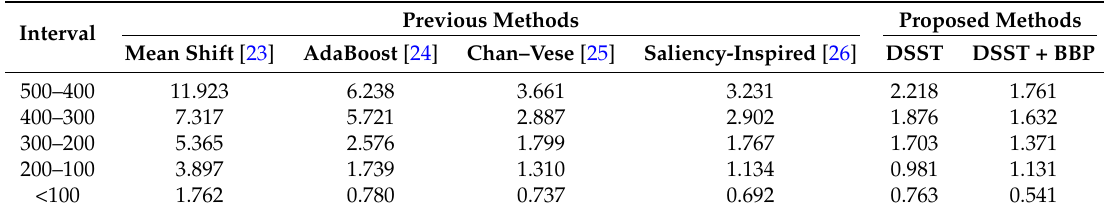
Table 8. Errors (m) in the j O , c -axis with tracking algorithms at separate intervals (m). Interval